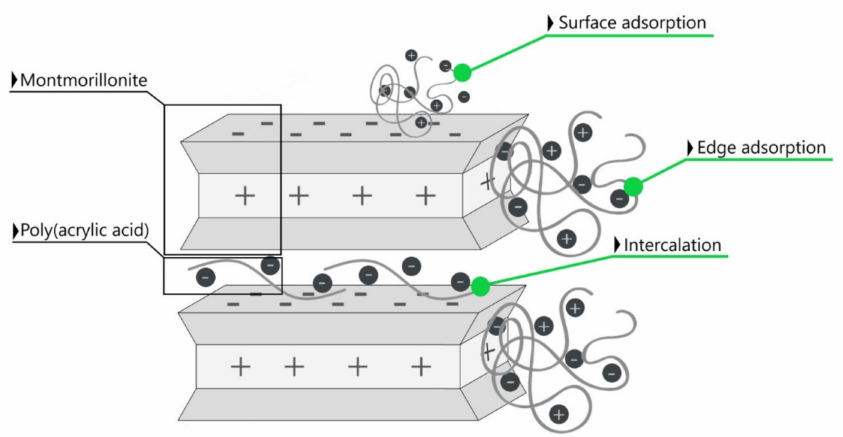
Figure 13. Scheme of some of the possible interactions of montmorillonite in calcium- and sodium- activated bentonite with the chains of poly(acrylic acid): surface and edge adsorption combined with the